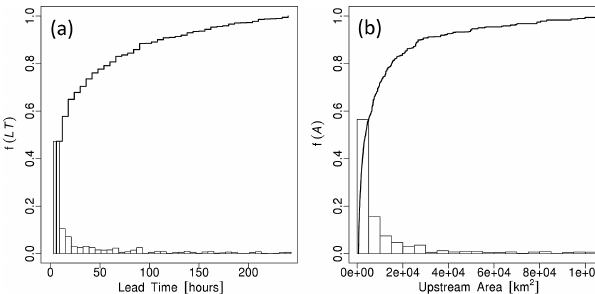
Figure 9. Pdf and cdf of lead time (a) and upstream area (b) of flood alerts detected by the ERI.